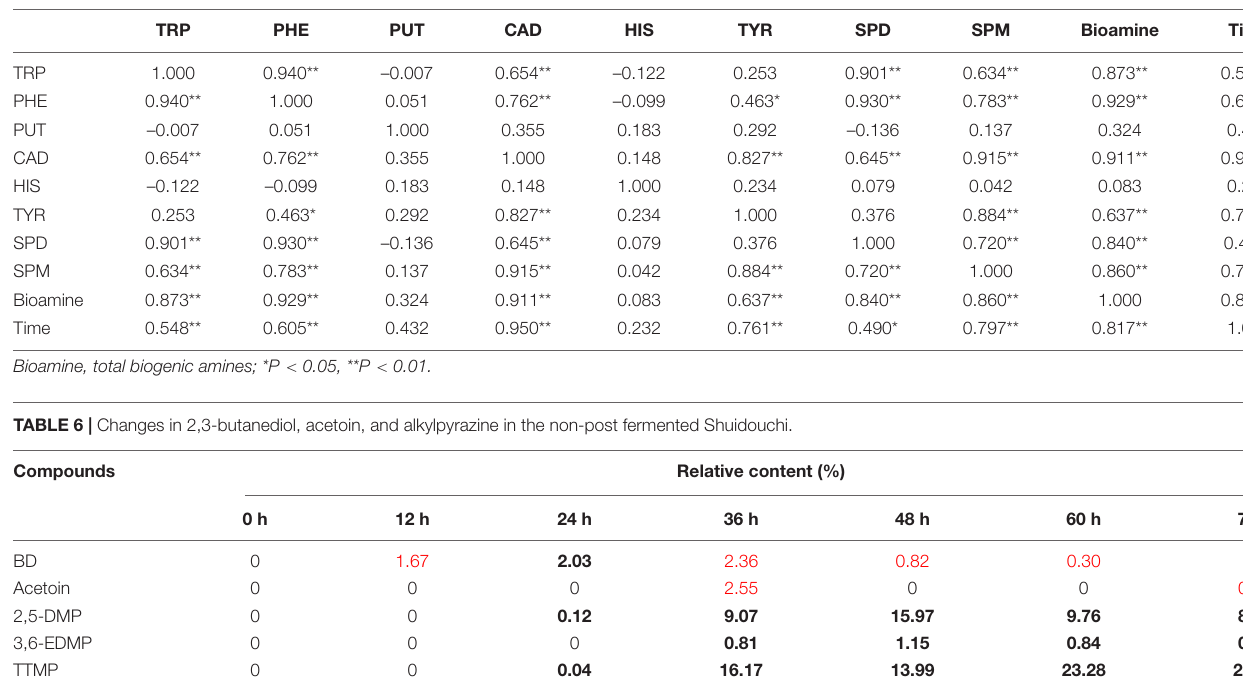
TABLE 5 | Pearson correlation coefficients of the biogenic amine index during fermentation of the non-post fermented Shuidouchi. TRP PHE PUT CAD HIS TYR SPD SPM Bioamine Time